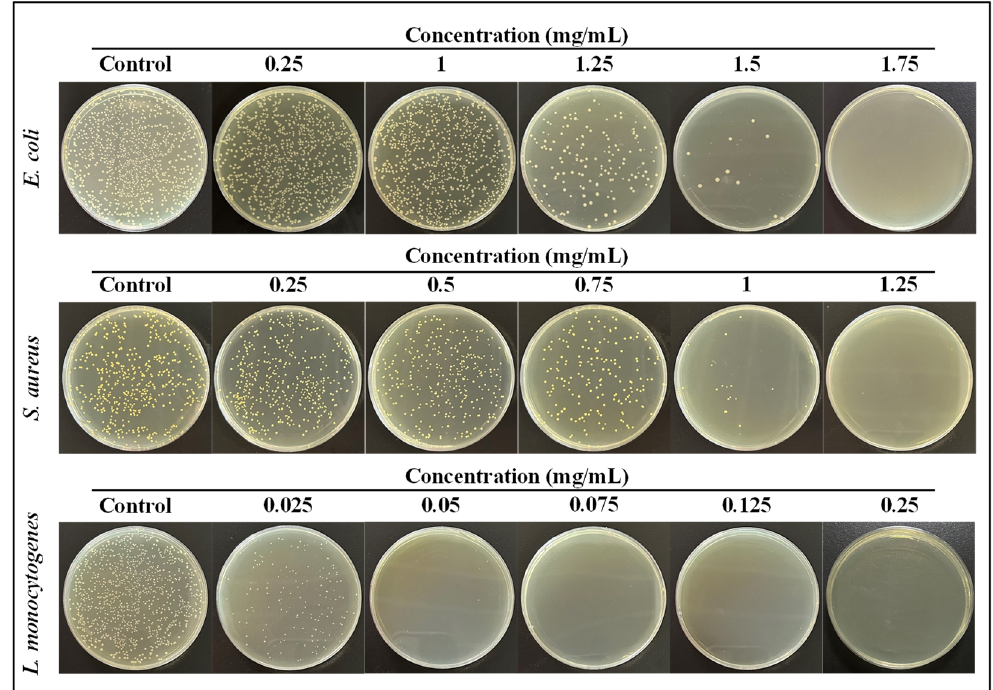
Figure 6. The bacterial colonies of GS-MGO nanohybrids against E. coli , S. aureus, and L. monocytogenes with different concentrations.